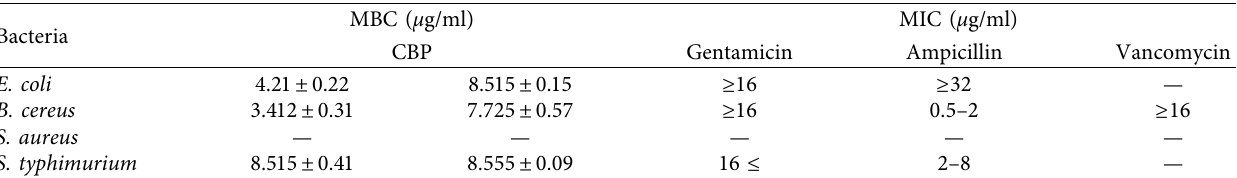
Table 7: Mean values of MIC and MBC for CBP peptide compared to commercial antibiotics against three pathogenic bacteria. MBC ( µ Bacteria